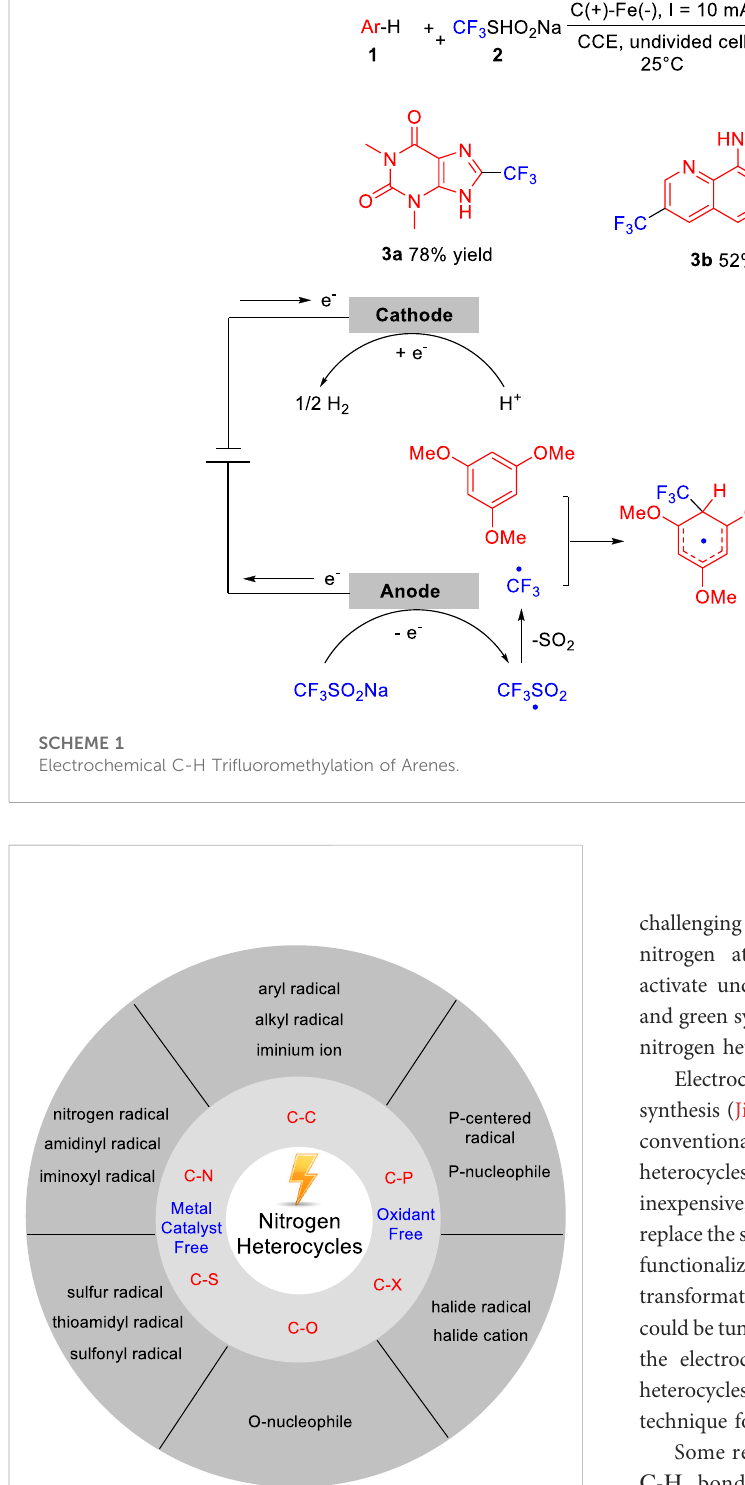
FIGURE 1 Electrochemical C-H Bond Functionalization of Nitrogen